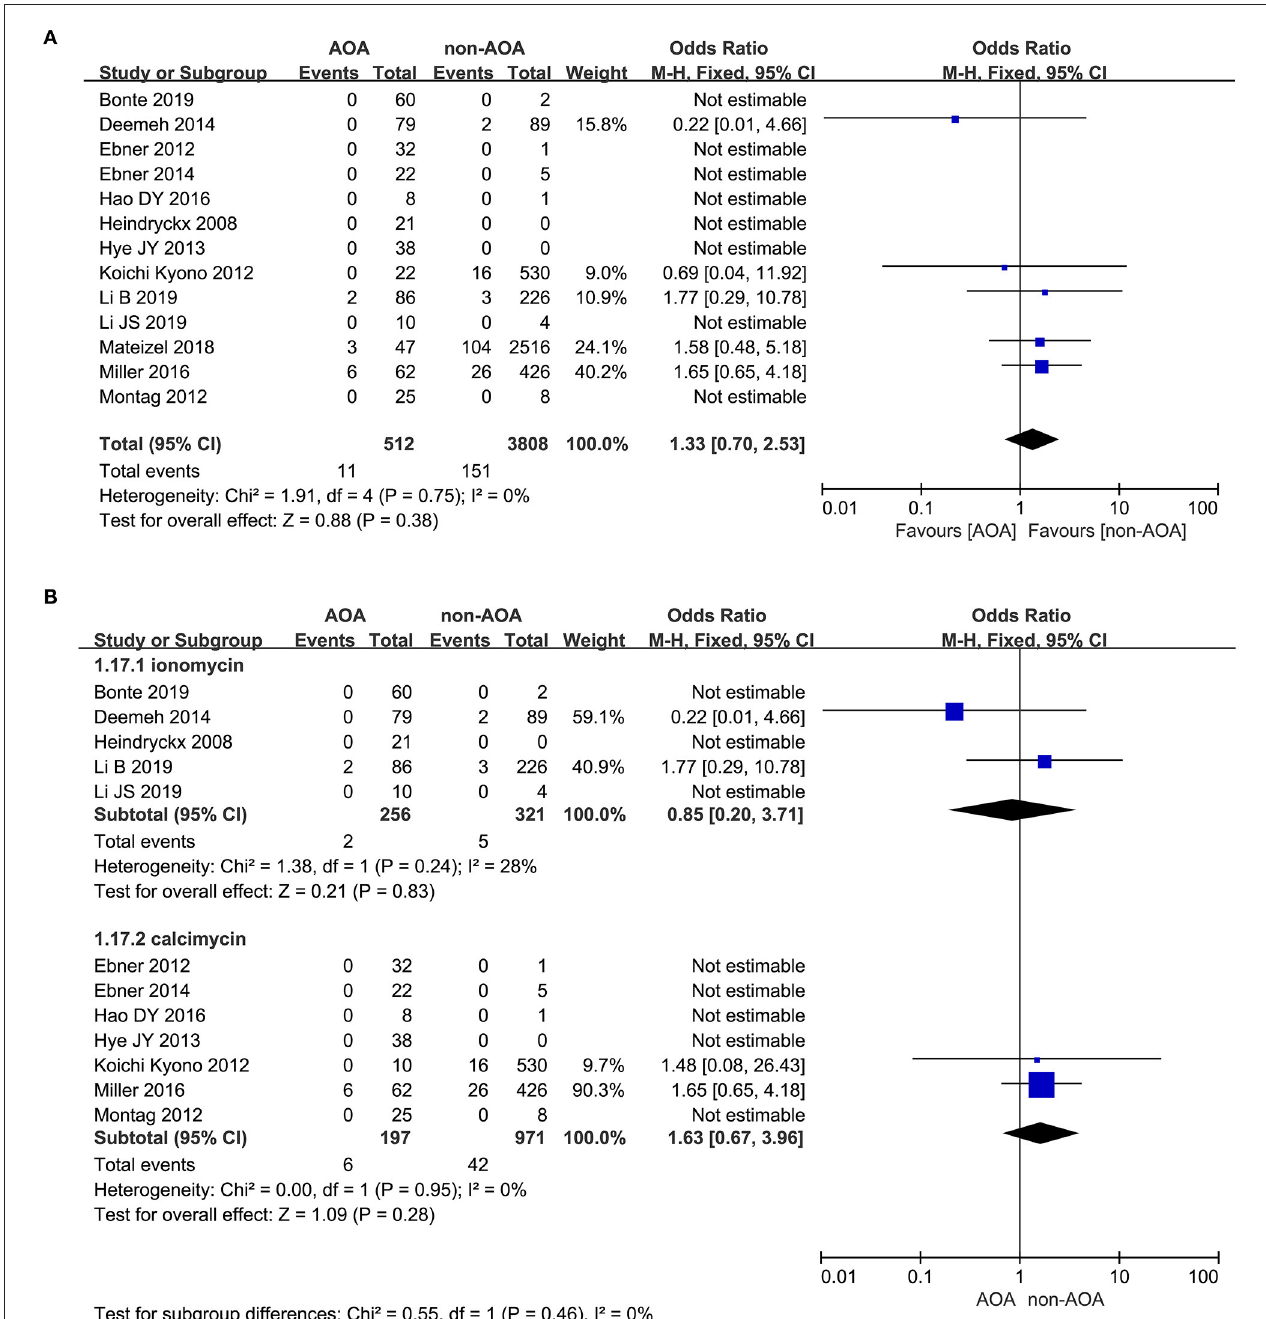
FIGURE 10 | (A) Forest plot of congenital birth defect rate between AOA treatment and non-AOA treatment patient groups using calcium ionophore. (B) The subgroup analysis of birth defect rate between AOA treatment and non-AOA treatment patient